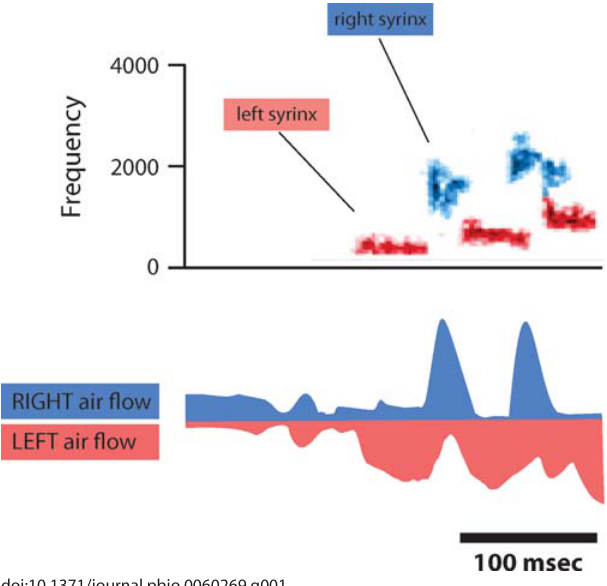
Figure 1. Songbirds Can Switch Rapidly between Sides When They Sing Many songbirds will use both their left and right syrinx to produce song. In some cases, as illustrated here by the brown-headed cowbird, they can switch rapidly from producing sound in the left syrinx to producing sound in the right syrinx. In this example, a cluster of five short song elements is produced within a very short period of about 200 ms. The contribution of each syringeal side can be measured by implanting a small heated microbead thermistor in each primary bronchus. These measure the rate of airflow through each side of the syrinx. The bottom portion of the figure shows the airflow through each bronchus with airflow from the right side in blue and left side in red. Note that left airflow has been flipped upside down to better compare with the right side. From these measurements, one can infer the syringeal source of each song element. As shown in the sonogram, cowbirds rapidly alternate between producing a note with the left (red) and the right (blue) sides of the syrinx. (Based on recordings performed in the cowbird by Rod